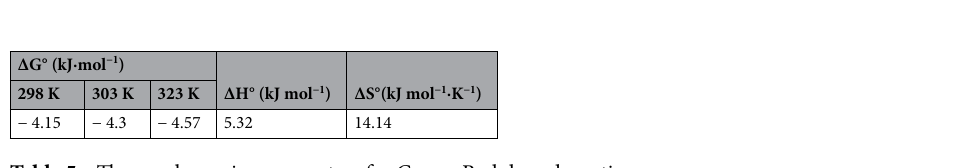
Figure 18. Van’t Hoff plot of the adsorption of Congo Red dye on FA.